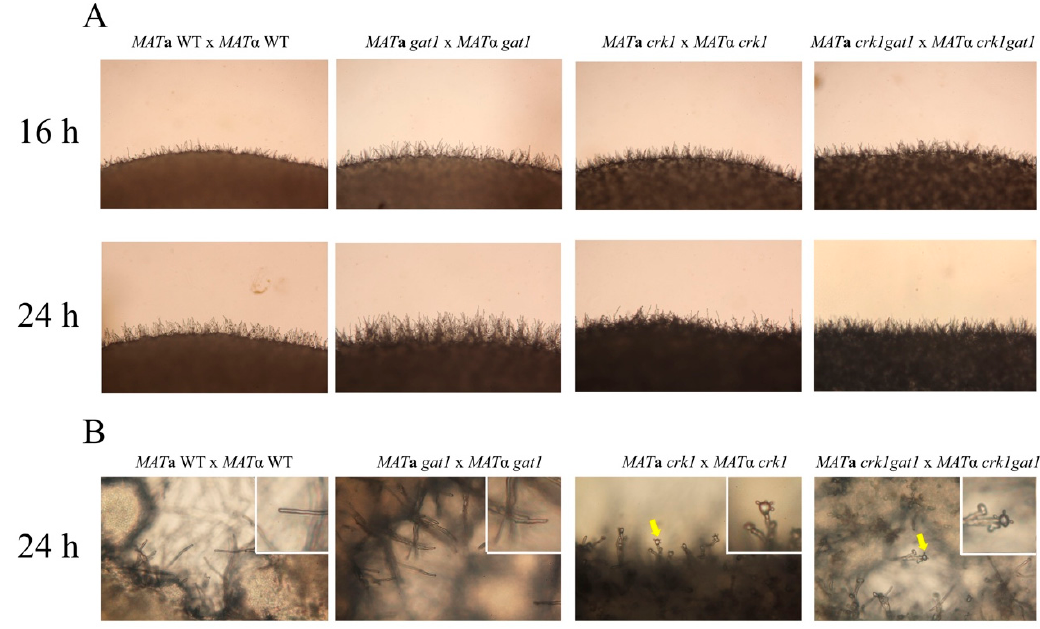
Figure 8. The crk1 and crk1gat1 mutants were phenotypically identical in bisexual mating. C. neoformans MAT a and MAT α gat1 , crk1 , and crk1gat1 mutant strains were crossed on V8 agar plates at 26 ° C in the dark and compared to the wild type strains. The edges of mating mixtures were photographed 16 h and 24 h post-incubation at 100× magnification. Photos of mating filaments were also recorded at 400× magnification. Small photos illustrate the tip of dikaryotic filament and yellow arrow indicates